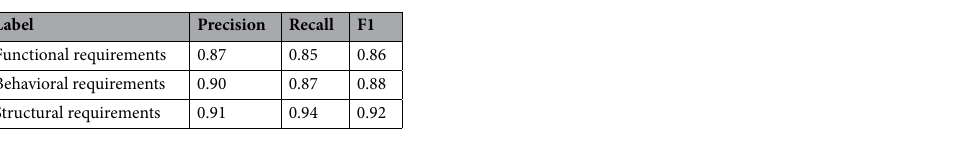
Table 2. Precision, Recall and F1 for customer requirements